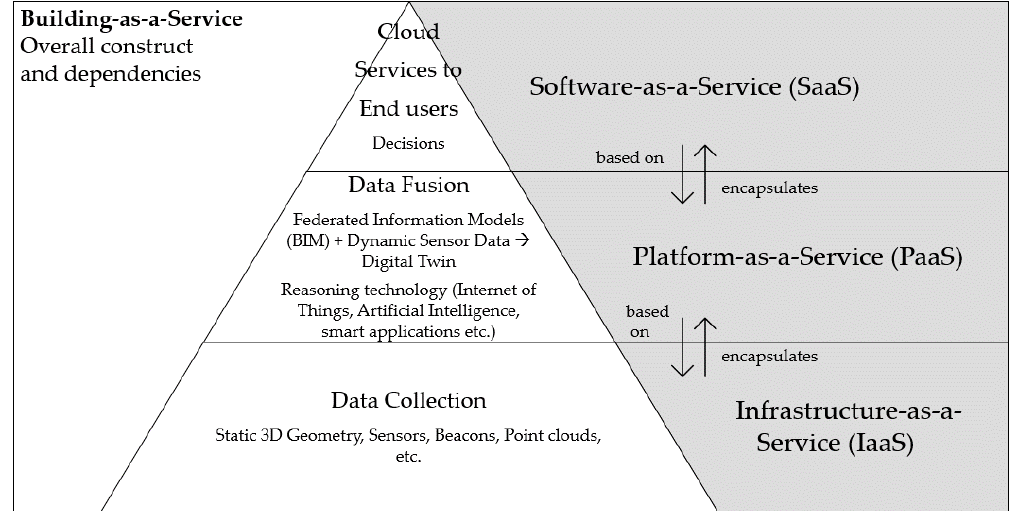
Figure 2. Building-as-a-Service Model.